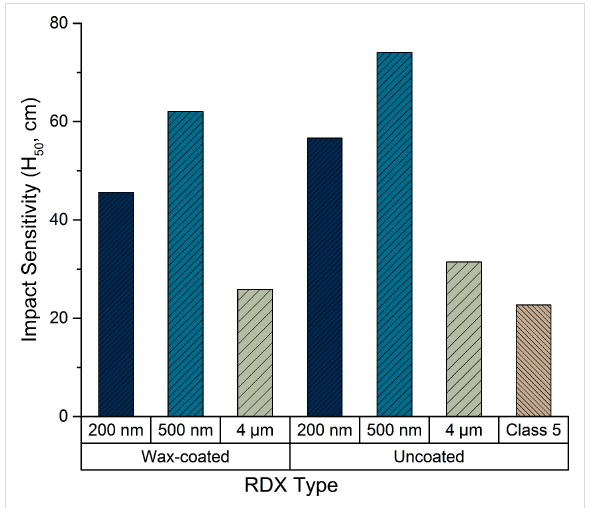
Figure 1: Impact sensitivity of RDX as a function of RDX type and par- ticle diameter, adapted from